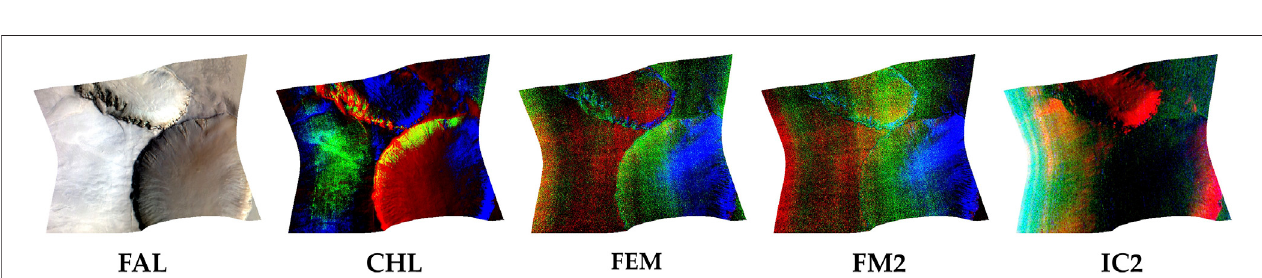
FIGURE 10 | CRISM Browse products results in eastern Asimov Crater. Footprints of data are shown with red polygons in Figure 2 .